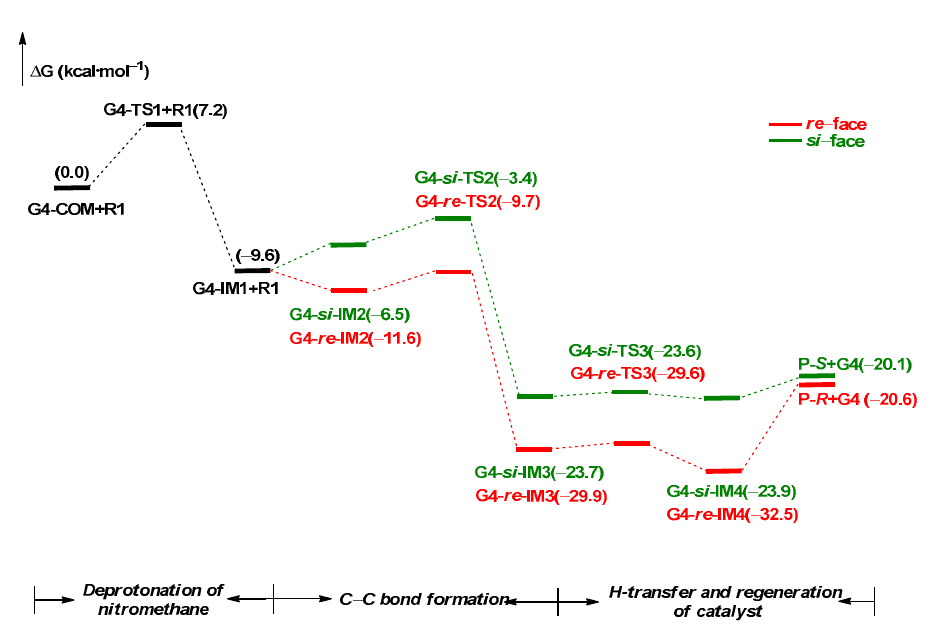
Figure 12. Energy profiles for aza-Henry reaction between N -Boc ketimine (R1a) and nitromethane (R2) catalyzed by G4 along re -face and si -face pathways,